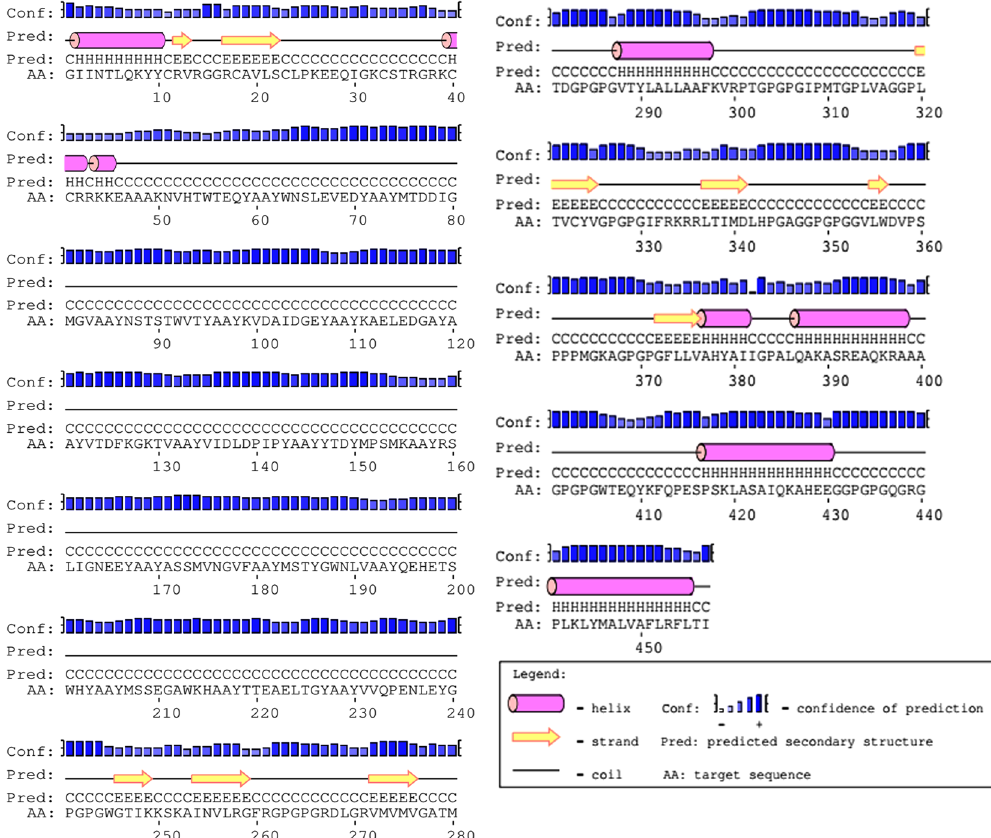
Figure 3. Schematic representation of secondary structure prediction of the multi-epitope vaccine, secondary structure prediction result represents the arrangement of α -helix (15.31%), β -strands (8.91%) and coils